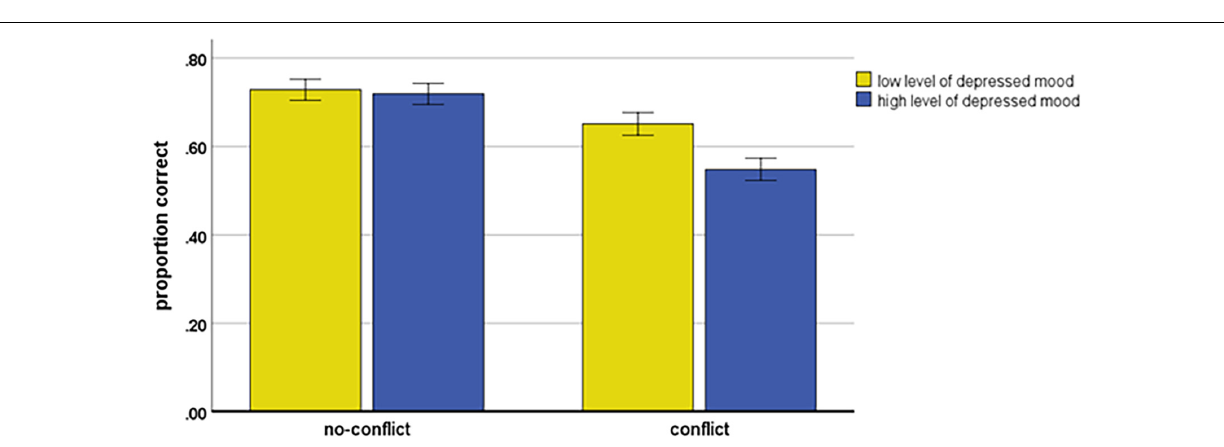
Frontiers in Psychology |